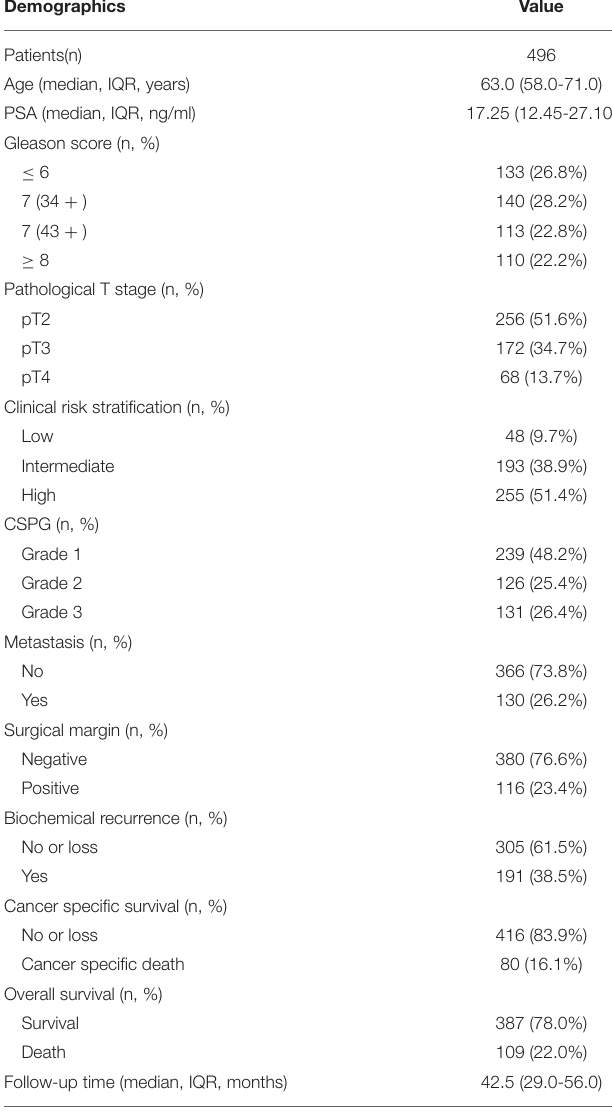
TABLE 1 | The demographics of patients in the study.